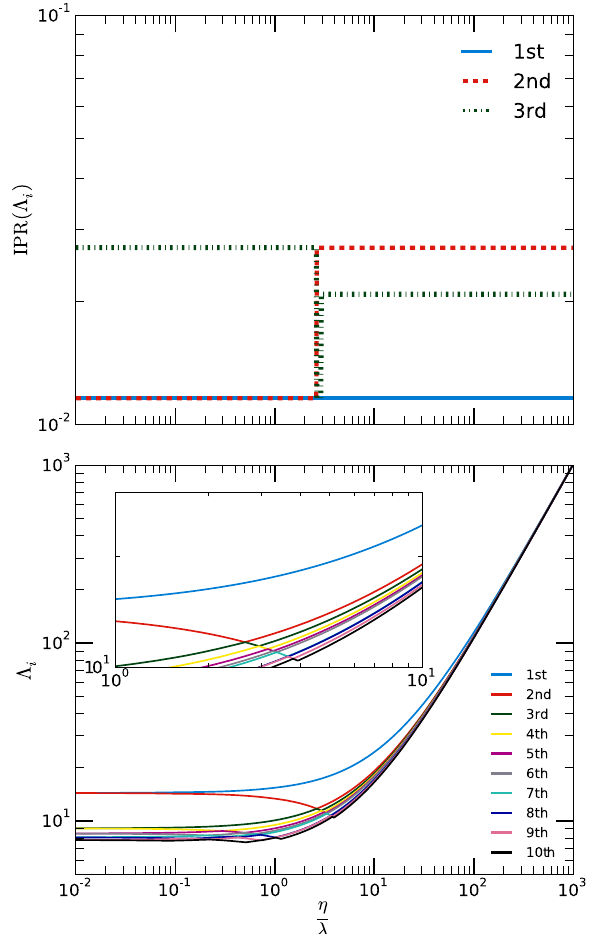
FIG. 10. Spectral properties of the tensor R ð λ ; η Þ as a function of the ratio η = λ for a multiplex with two layers with the exact same degree distribution and connected to its counterpart on the other layer. In the top panel, we present the inverse participation ratio of the three larger eigenvalues, while in the bottom panel, we show the leading eigenvalues. Every curve is composed of 10 3 log spaced points, in order to have enough